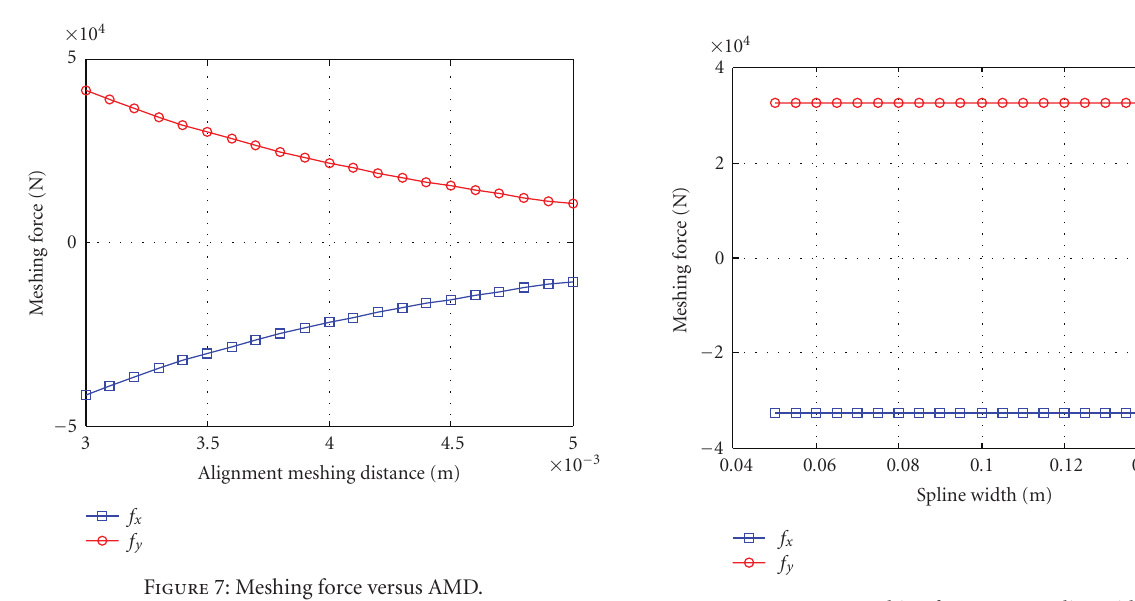
Figure 9: Meshing force versus spline